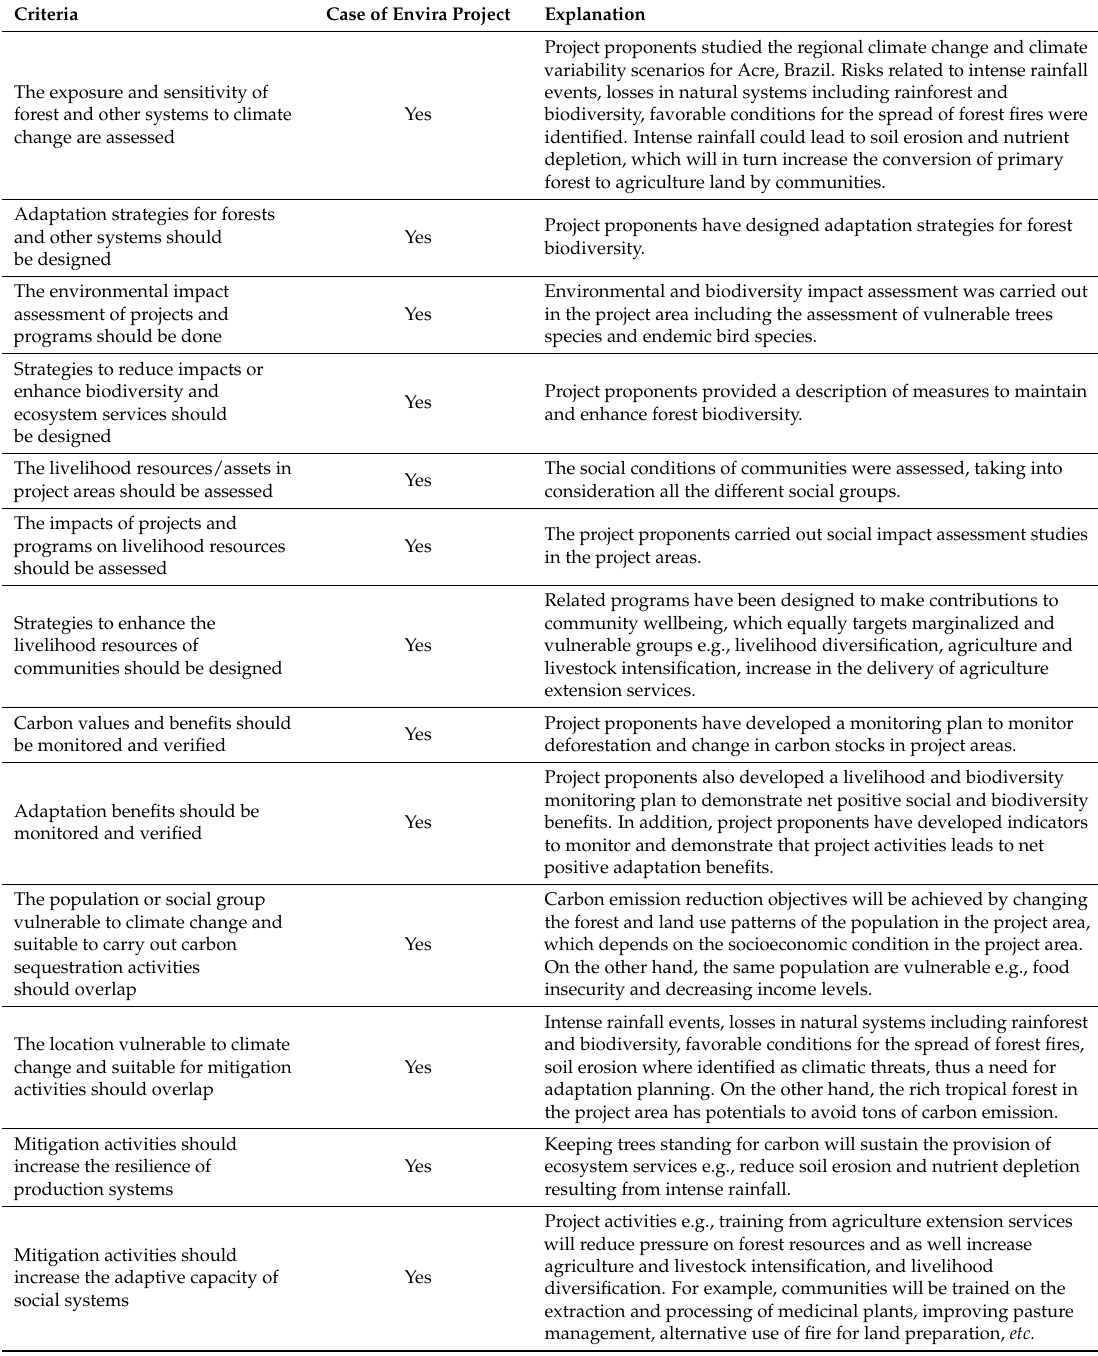
Table 5. Analyzing project design with the conditions for planning and expecting synergy outcomes.